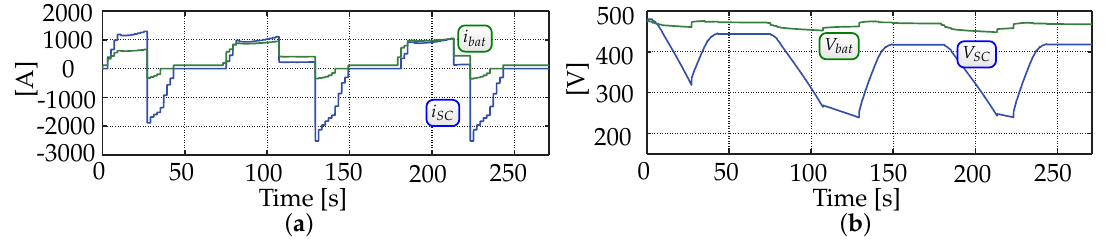
Figure 8. Simulation results for the proposed sliding forward window optimization EMS with three typical stops in the driving cycle of the LR: ( a ) battery current and SC current and ( b ) battery voltage and SC